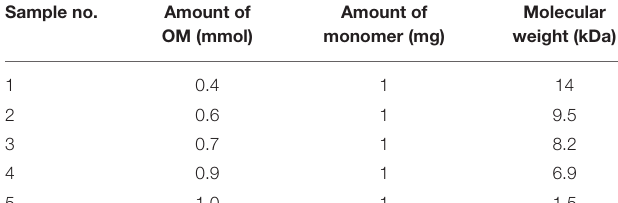
TABLE 1 | Chain length variation of the polymer by changing the amount of catalyst. Sample no.